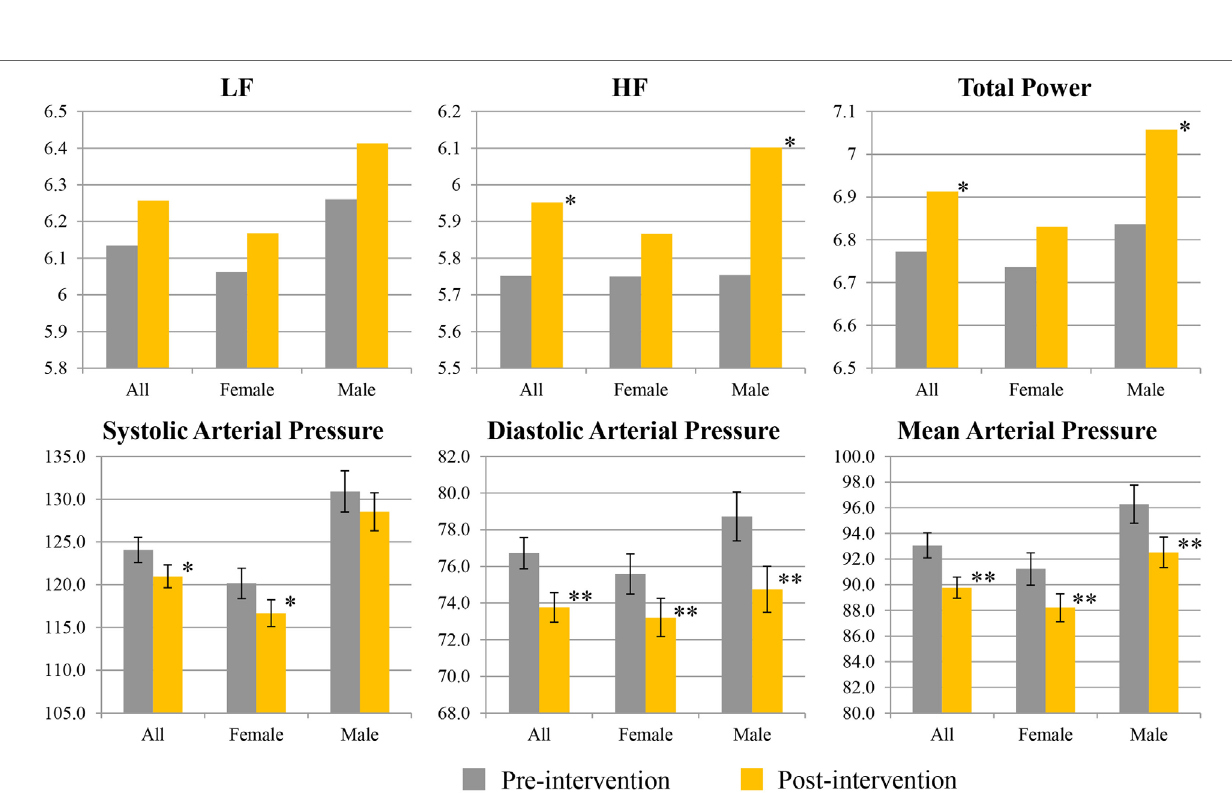
FigUre 3 | Pre- and post-interventional values for spectral measures of heart rate variability, and blood pressure. Values for low frequency (LF), high frequency (HF), and total power are given as natural logarithms of the absolute values. Values for systolic, diastolic, and mean arterial pressure are given as millimeters of mercury. Single asterisk indicates 0.1 ≤ p ≤ 0.05; double asterisks indicate p <